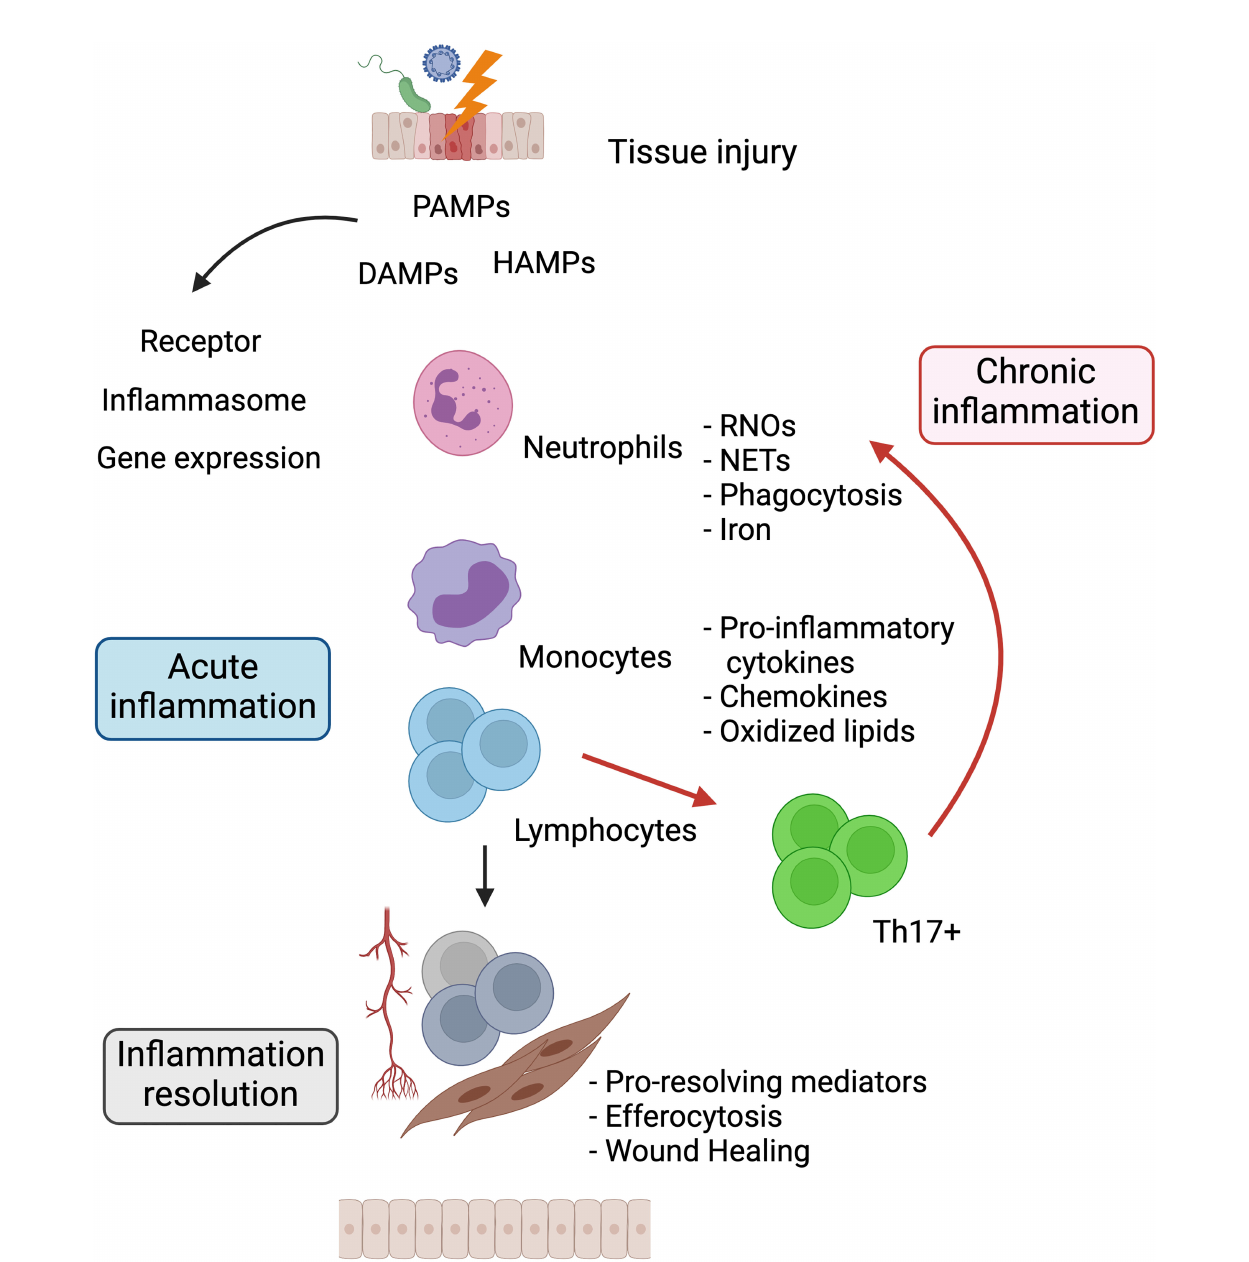
FIGURE 1 | The relationship between acute and chronic in fl ammation. Harmful agents that damage tissues trigger the release of PAMPs, DAMPs, and HAMPs. Surrounding tissue cells sense these molecules through surface or intracellular receptors that trigger signaling pathways for the production of proin fl ammatory chemokines and cytokines. These soluble factors promote the migration of neutrophils and monocytes to the site of injury producing RNOs, NETs, increased iron, and phagocytizing noxious agents. Once the source of damage is eliminated, resolution of in fl ammation is induced, mediated by immunoregulatory cells and suppressor cytokines, restoring tissue homeostasis. Dysregulation and perpetuation of the aforementioned processes cause chronic in fl ammation. PAMPs, Pathogen-associated molecular patterns; DAMPs, Damage-associated molecular patterns; HAMPs, Homeostasis-altering molecular processes; RNOs, Reactive oxygen and nitrogen species; NETs, Neutrophil extracellular traps. Created with